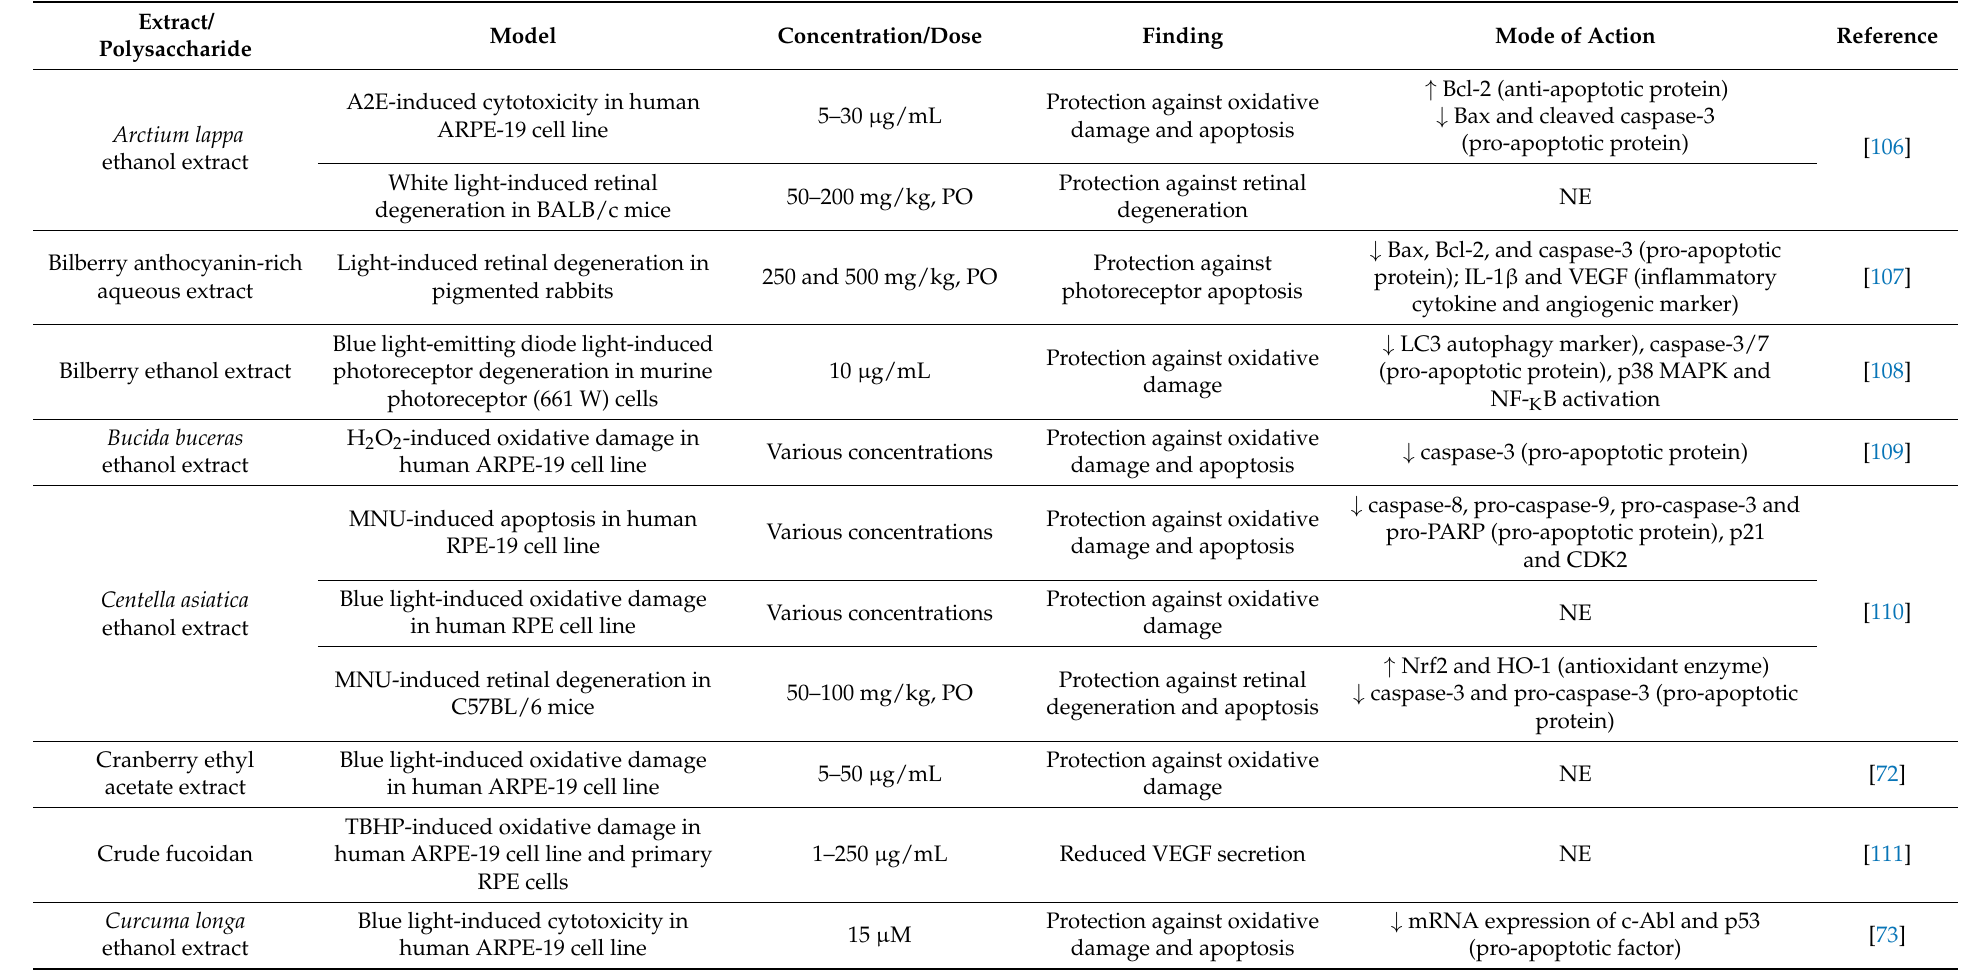
Table 3. Extracts and polysaccharides in the alleviation of